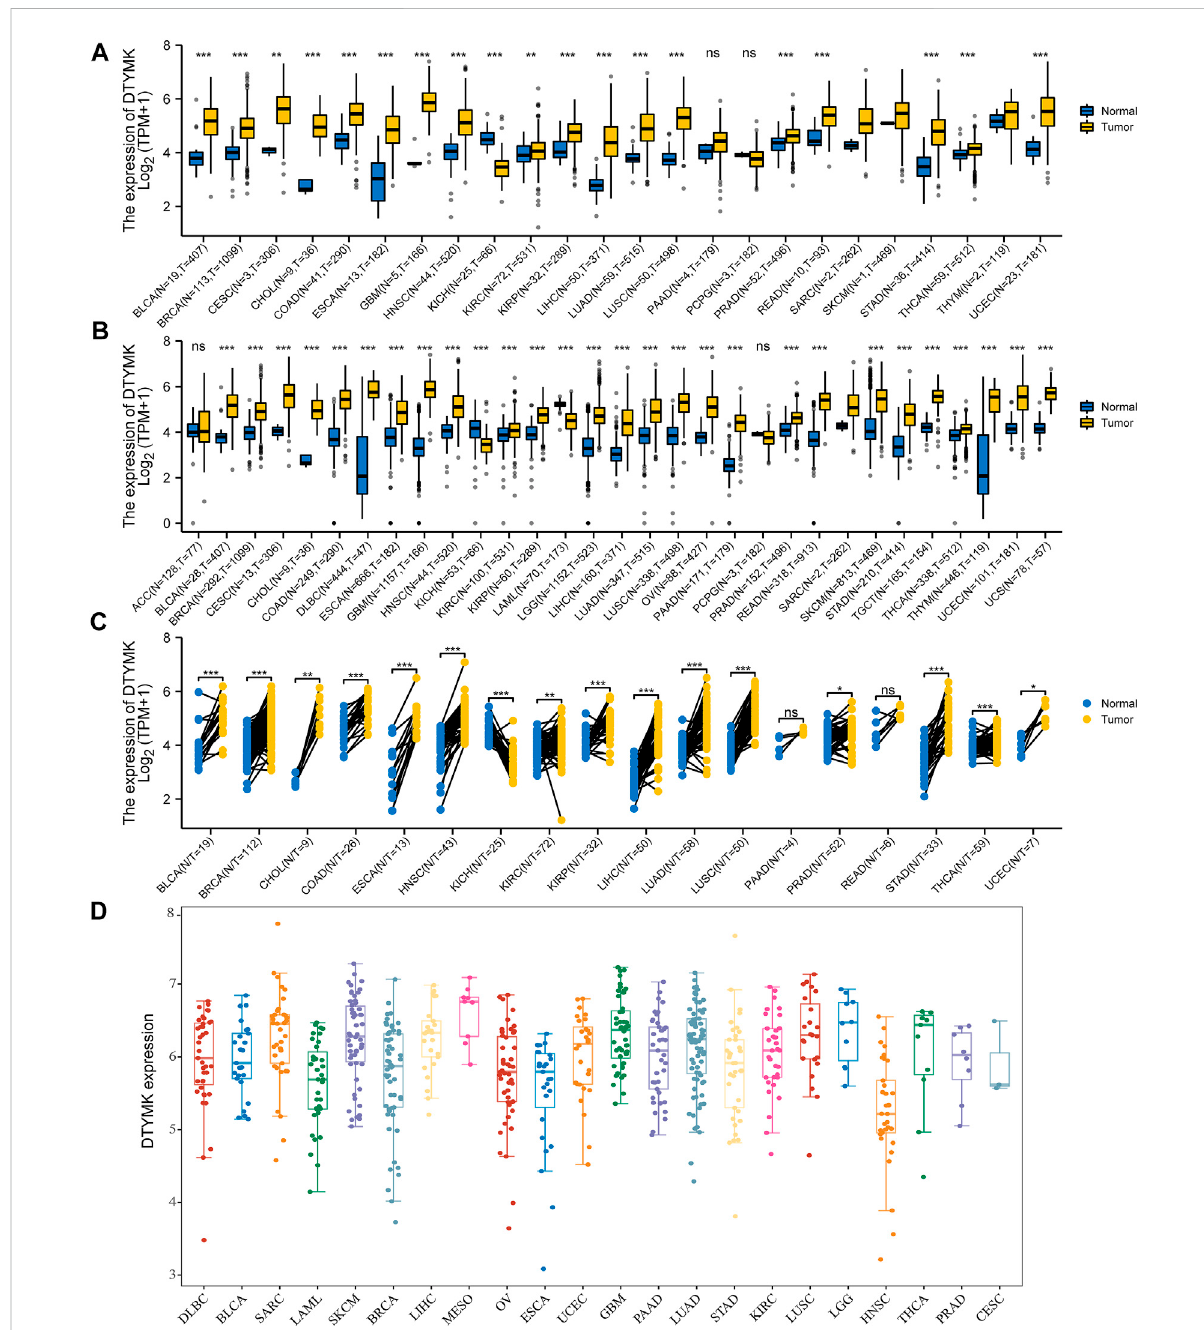
FIGURE 1 DTYMK expression in Pan-Cancer perspective. (A) Differential analysis of DTYMK expression with data from TCGA. (B) TCGA and GTEx data indicateddifferentialexpressionofDTYMKinthePan-Cancer perspective. (C) Pairedt-testwithTCGAdata. (D) DTYMKexpressionindifferenttumor cell lines from CCLE was in higher ranges. (ns, no signi fi cant; *, p < 0.05, **, p < 0.01, ***, p <